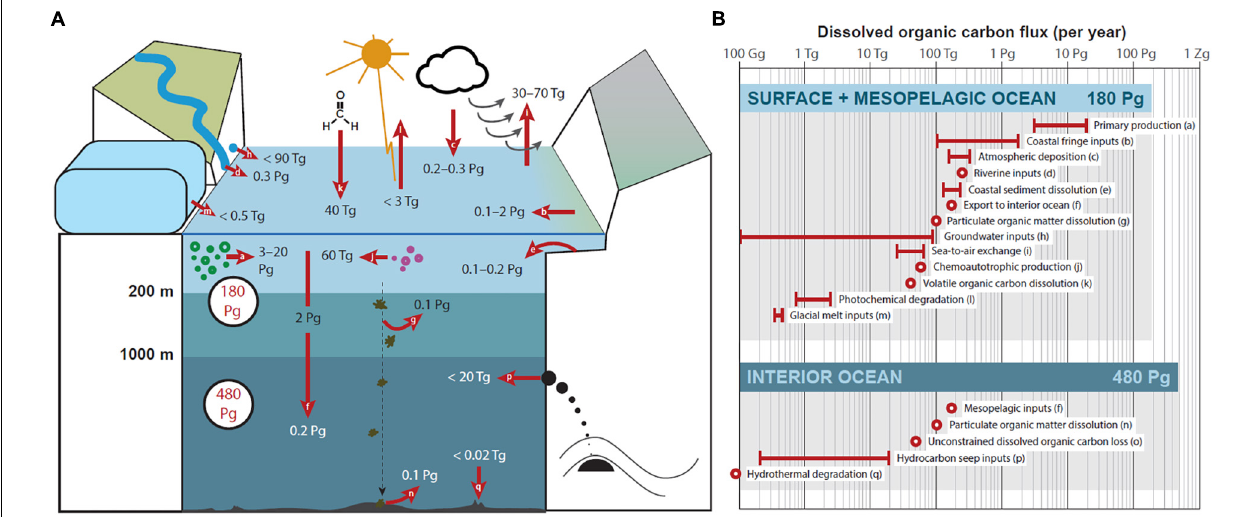
FIGURE 1 | The current understanding of dissolved organic carbon (DOC) fluxes in the surface, mesopelagic, and interior ocean. In panel (A) oceanic DOC stocks are shown in black circles with red font and units are Pg-C. DOC fluxes are shown in black and white font and units are either Tg-C yr − 1 or Pg-C yr − 1 . Letters in arrows and associated flux values correspond to descriptions displayed in (B) , which lists sources and sinks of oceanic DOC described in the text (see section “Current Understanding of Marine